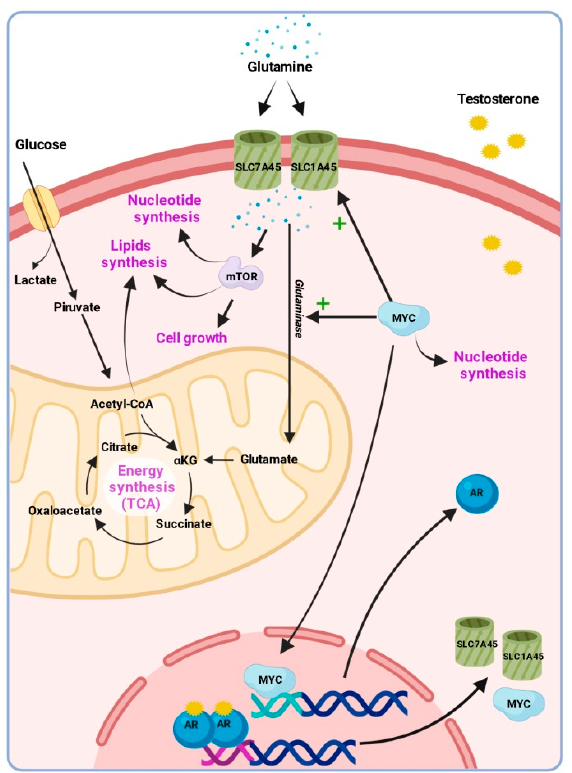
Figure 7. A scheme representing the relationship between glutamine metabolism and androgen receptor (AR) signalling. AR upregulates the expression of glutamine transporters and the MYC oncogene, which also promotes the transcription of AR. MYC also activates glutamine transport and glutaminase activity, which convert glutamine to glutamate and enters the tricarboxylic acid cycle (TCA) to synthesise energy. Glutamine metabolism is also involved in lipids synthesis. Glutamine also participates in the activation of the mammalian target of rapamycin (mTOR), which stimulates lipid and nucleotide synthesis, cell growth and differentiation.